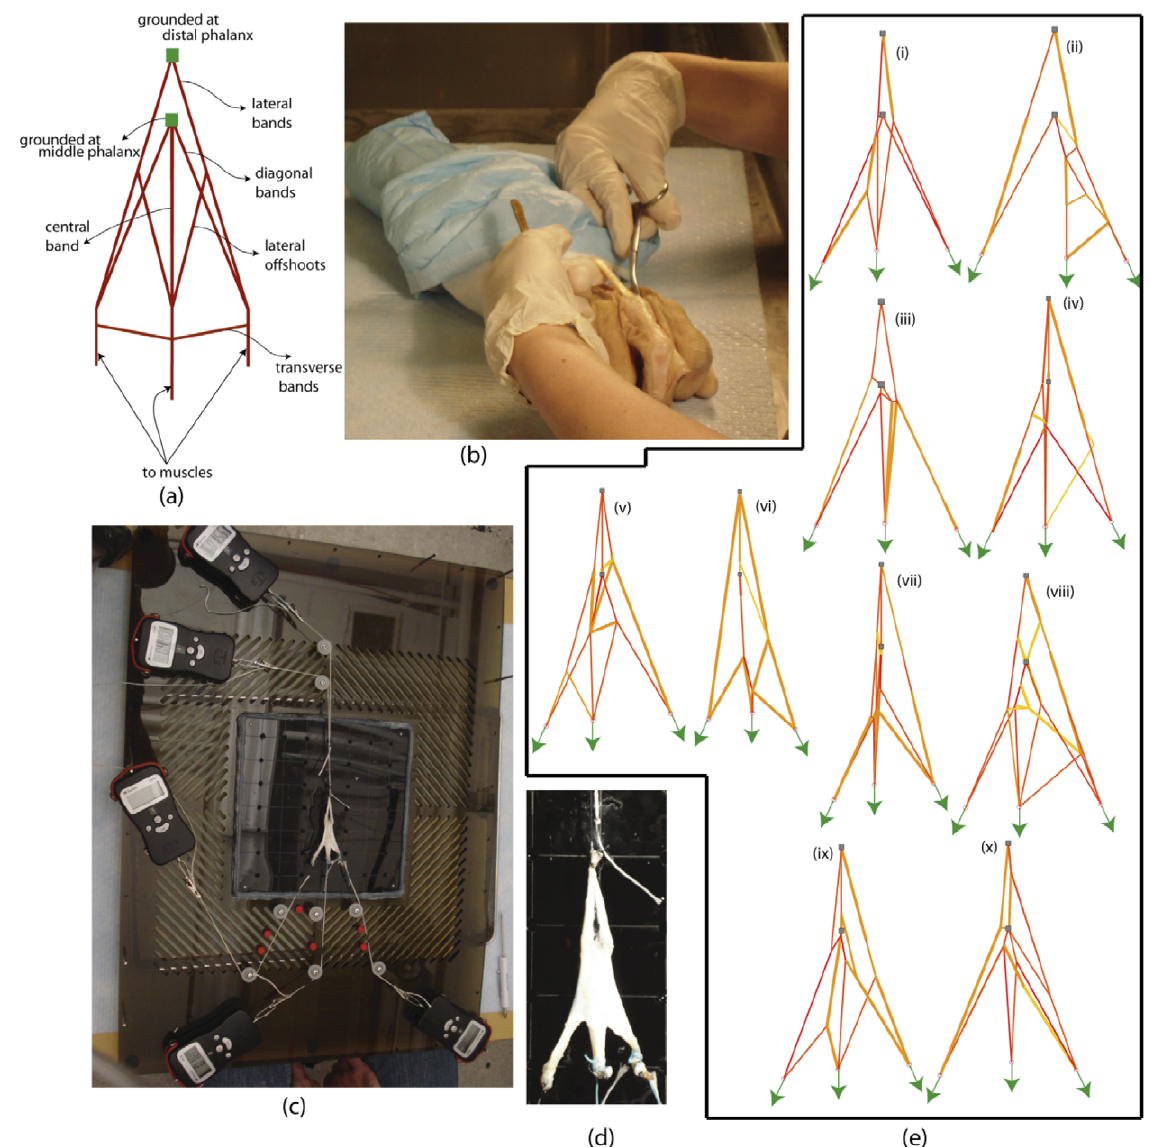
Figure 4. Structural inference of the finger extensor mechanism extracted from the middle finger of a human cadaver hand. (a) The interpretation by Zancoli [17] and Garcia-Elias [18] as Winslow’s Rhombus is widely accepted. A characteristic of this structure is the overlap between the lateral offshoot and the diagonal band on both symmetric sides. (b) The extensor tissue was carefully extracted during the day of the experiment. (c) the tissue mounted over the experimental bed for force-motion data extraction (d) magnified view of the extensor tissue (e) ten best inferred networks that are all functionally equivalent within the training set and cross validation errors of 7.9% and 7.2% respectively (Table 2). The models are structurally diverse. Strings colored yellow are not taut in the equilibrium configuration shown. Those colored red are taut. Slack strings do become taut when some other test, used to infer the model network, is employed. Models (i), (iv), (viii) and (ix) in (e) structurally resemble with the Winslow’s rhombus in (a) with notable deviations besides the presence of additional strings. In model (i), all modules according to the classical description in (a) are captured except for the left lateral offshoot which is shorter in length. In (iv), a string connects the middle and terminal slips. In (viii), the central band is replaced by a diamond. In model (ix), the left lateral offshoot does not overlap with the left diagonal band but instead, is fused with